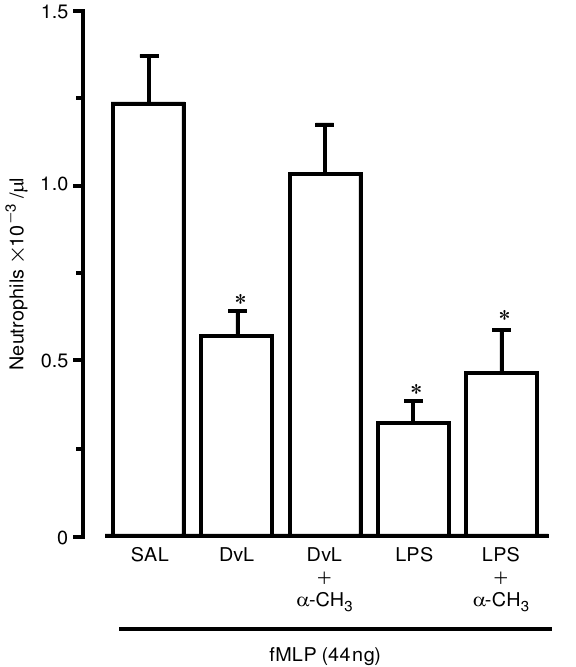
FIG. 4. The inhibitory effect of D. violaceae lectin (DvL) on fMLP-induced neutrophil migration is not due to endotoxin contamination. DvL (1 · 0 mg / kg) or LPS (30 m g / kg) were injected i.v. alone or in combination with a -CH 3 (0 · 1 M) 30 min before i.p. injection of fMLP (44 ng). The cell counts were made 4 h after the in¯ ammatory stimulus challenge. SAL refers to animals that received saline intravenously and fMLP intraperitoneally. Values are mean SEM for the number of animals used (n = 5 - 10). Indicates a signi® cant statistical difference ( P , 0.05) compared to the SAL group (ANOVA, Duncan’s test).